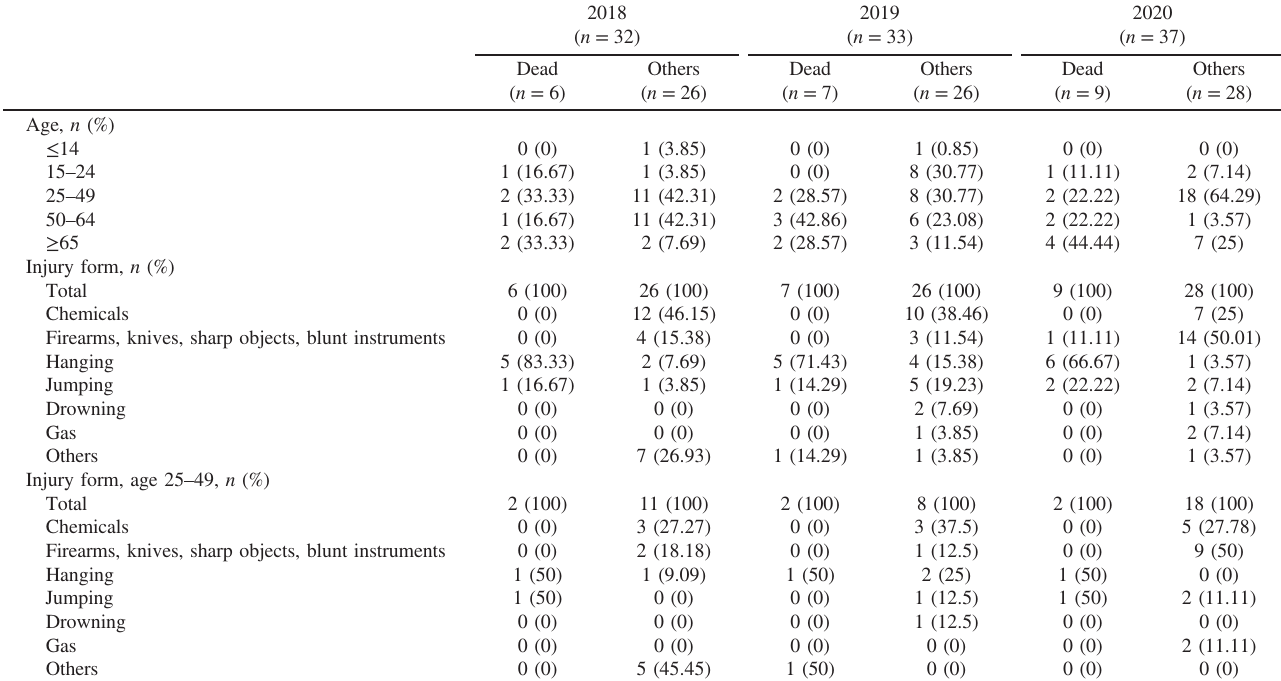
Table 3. Characteristics of suicide attempts by severity among men obtained from information on emergency dispatches in Okayama